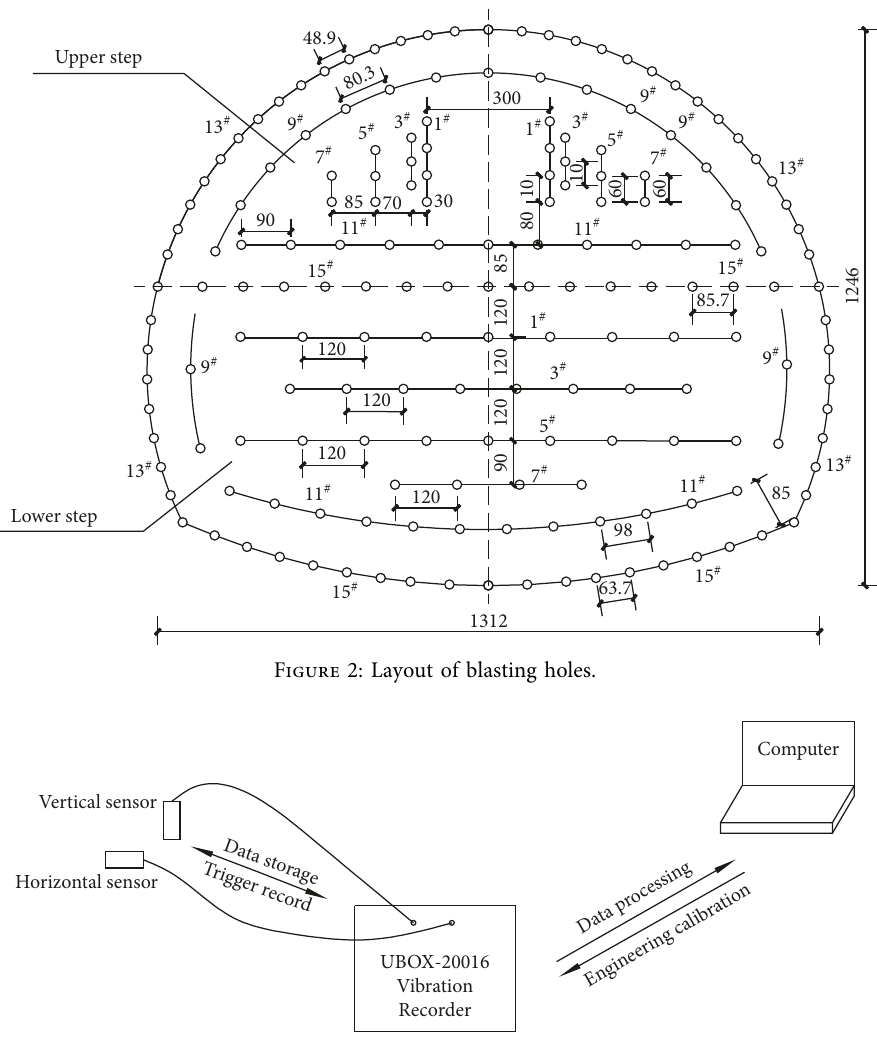
Figure 3: Schematic diagram of blasting vibration monitoring.